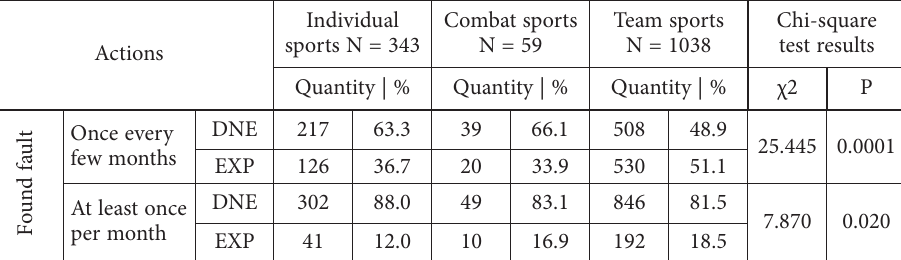
Table 3. Frequency and nature of bullying and harassment actions: individual, combat, team sports types (b)